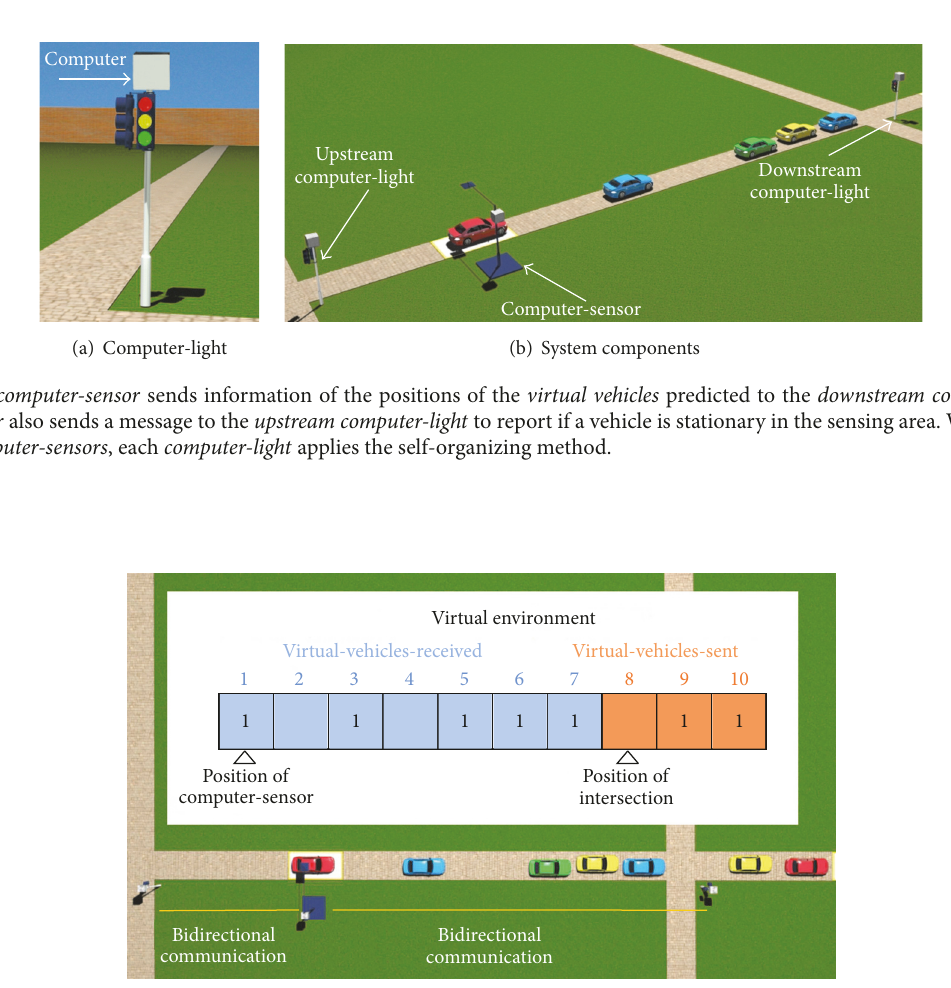
Figure 7: Each computer-sensor uses a local simulation to predict the vehicles between the computer-sensor and the downstream computer- light